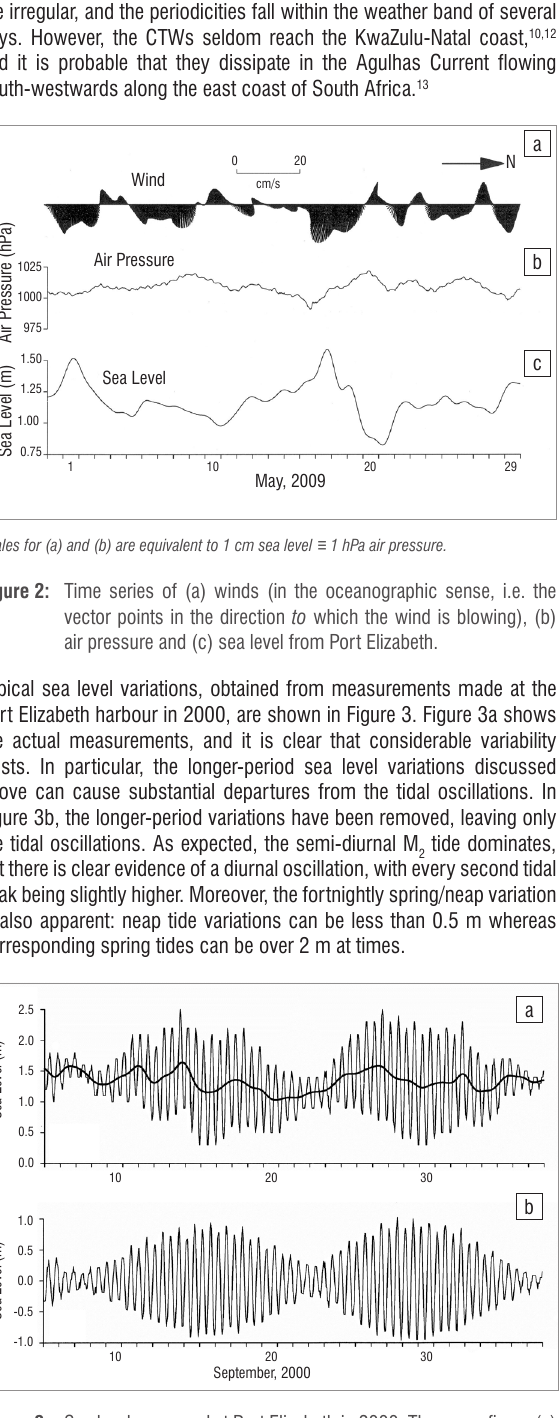
The estuarine response to changes in adjacent sea level can be complex, and varies with the different periods involved; as already indicated, the emphasis here will be on tidal and longer periods. The discussion is divided into two parts: the first dealing with sea level variability near the mouth of the estuaries and the second the manner in which the different signals from the sea propagate landward into the